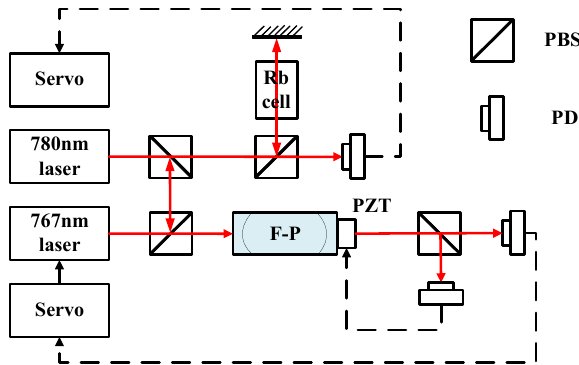
Figure 9. Block diagram of frequency stabilization experimental system. PBS: polarizing beam splitter; PD: photo detector; PZT: piezoelectric transducer. (Figure reproduced from [67].)